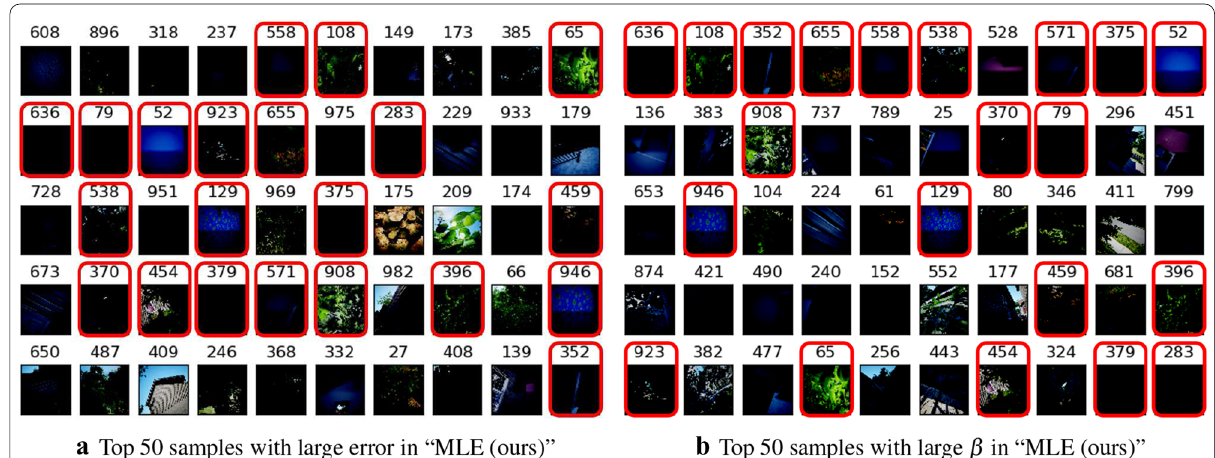
Fig. 8 Sorted samples. A number above each image is a index of a sample. In ( a ), top 50 samples are sorted in descending order of the error in “MLE (ours)”. Error of sample#608 in the regression model is φ error = − 35.34 deg, θ error = − 25.74 deg . Error of sample#352 is φ error = 2.80 deg, θ error = − 12.93 deg . In ( b ), top 50 samples are sorted in descending order of β in “MLE (ours)”. Mutual samples of the both groups are marked with red